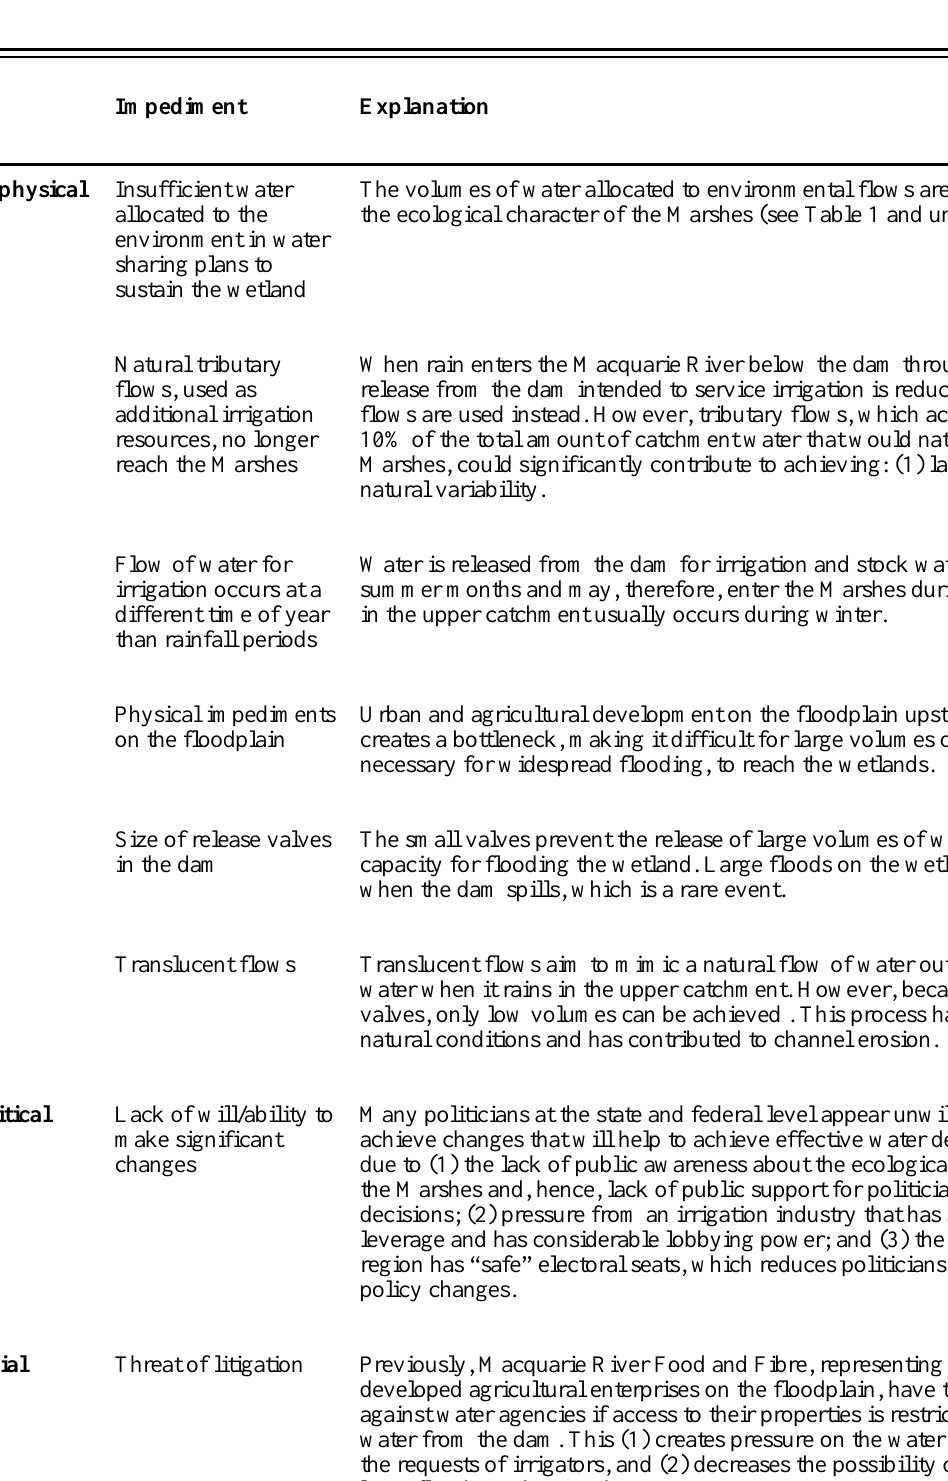
Table 2. Impediments to achieving effective delivery of water to the